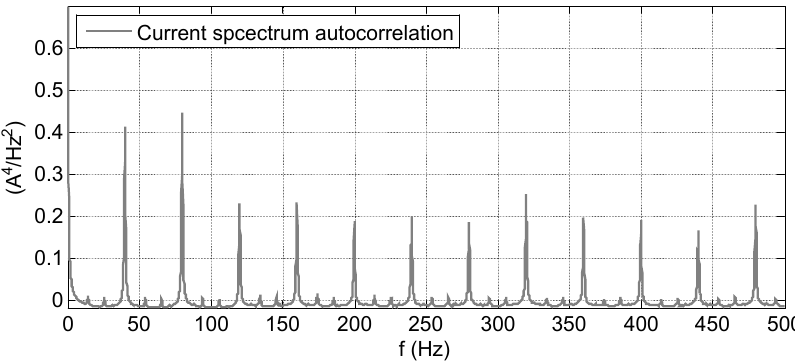
Figure 5. Current spectrum autocorrelation obtained according to the proposed method.